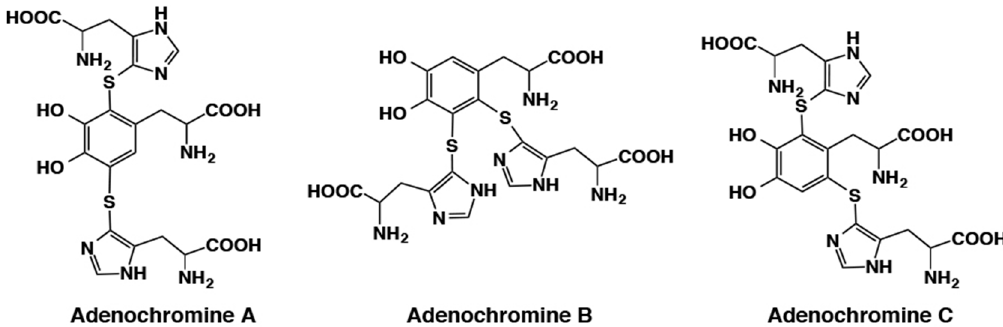
Figure 7. Three structural isomers of di-adducts of 5-thiohistidine to dopa isolated from Octopus vulgaris [39,40]. Note that adenochromine A, B, and C correspond to the 2,5-, 5,6-, and 2,6-adducts, respectively.